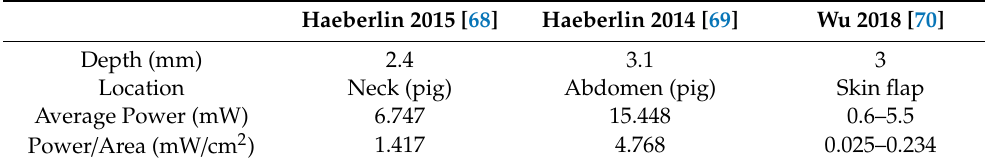
Table 3. Comparison of select photovoltaic energy harvesting implants.